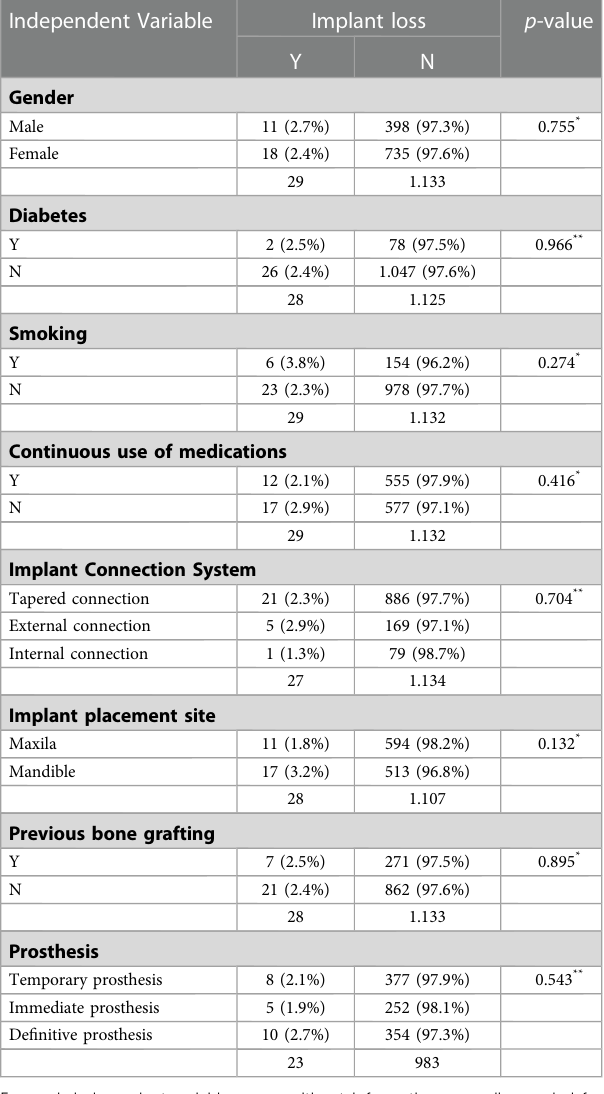
TABLE 1 Absolute and relative frequencies (%) of implant loss according to sex, diabetes, smoking, continuous use of medications, type of implant system, location of installation, previous bone grafting and type of prosthetic provisioning. Independent